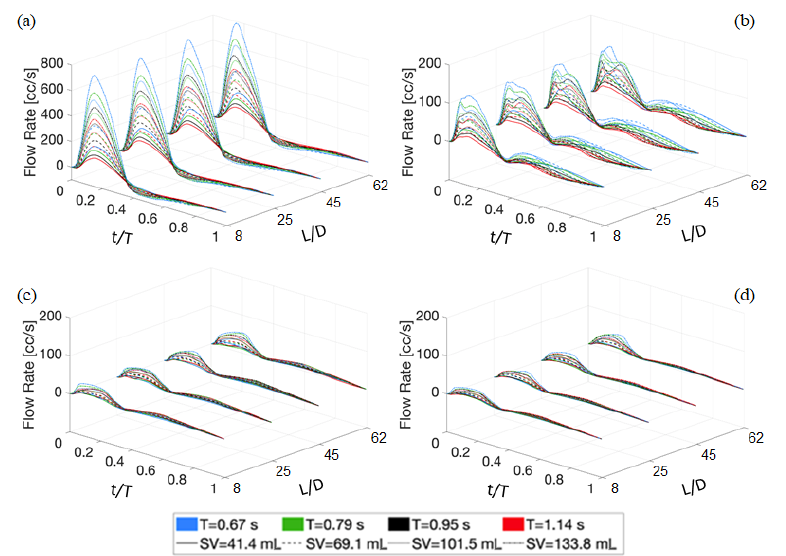
Figure 9. Effect of SV , T , and L / D on the deterministic waveforms of the flow rate at the four outlets of the healthy aorta: ( a ) DA, ( b ) BCA, ( c ) LCCA, and ( d )